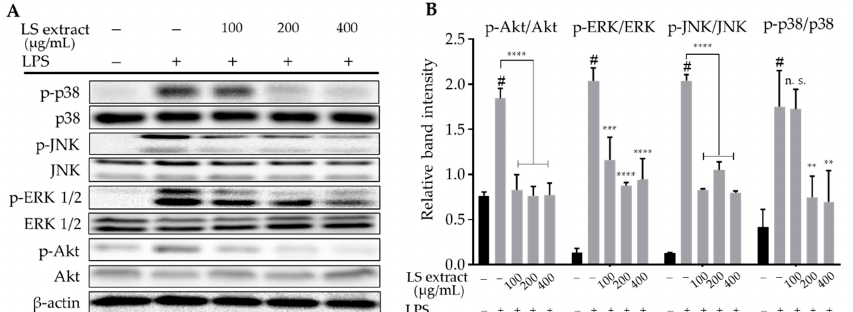
Figure 7. Effects of LS leaf extract on LPS-induced activation of mitogen-activated protein kinases (MAPKs) and phosphoinositide-3-kinase / protein kinase B (PI3K / Akt) pathways in RAW 264.7 cells. Cells were pretreated with LS leaf extract for 24 h, followed by LPS (1 µ g / mL) stimulation for 18 h. The expression of p-p38, p38, p-c-Jun N-terminal kinase (JNK), JNK, p-extracellular signal-regulated kinases 1 / 2 (ERK 1 / 2), ERK1 / 2, p-Akt, and Akt was analyzed by Western blot ( A ). β -actin was used as a loading control. The relative band intensity of phosphorylated (p-) target protein compared to total target protein was quantified using Image J ( B ) ( n = 3). Values represent the mean ± SD. Statistical significance was calculated by t -test and one-way ANOVA. # p < 0.05 vs. cells treated with media only; n. s., not significant; ** p < 0.01, *** p < 0.001, and **** p < 0.0001 vs. cells treated with LPS